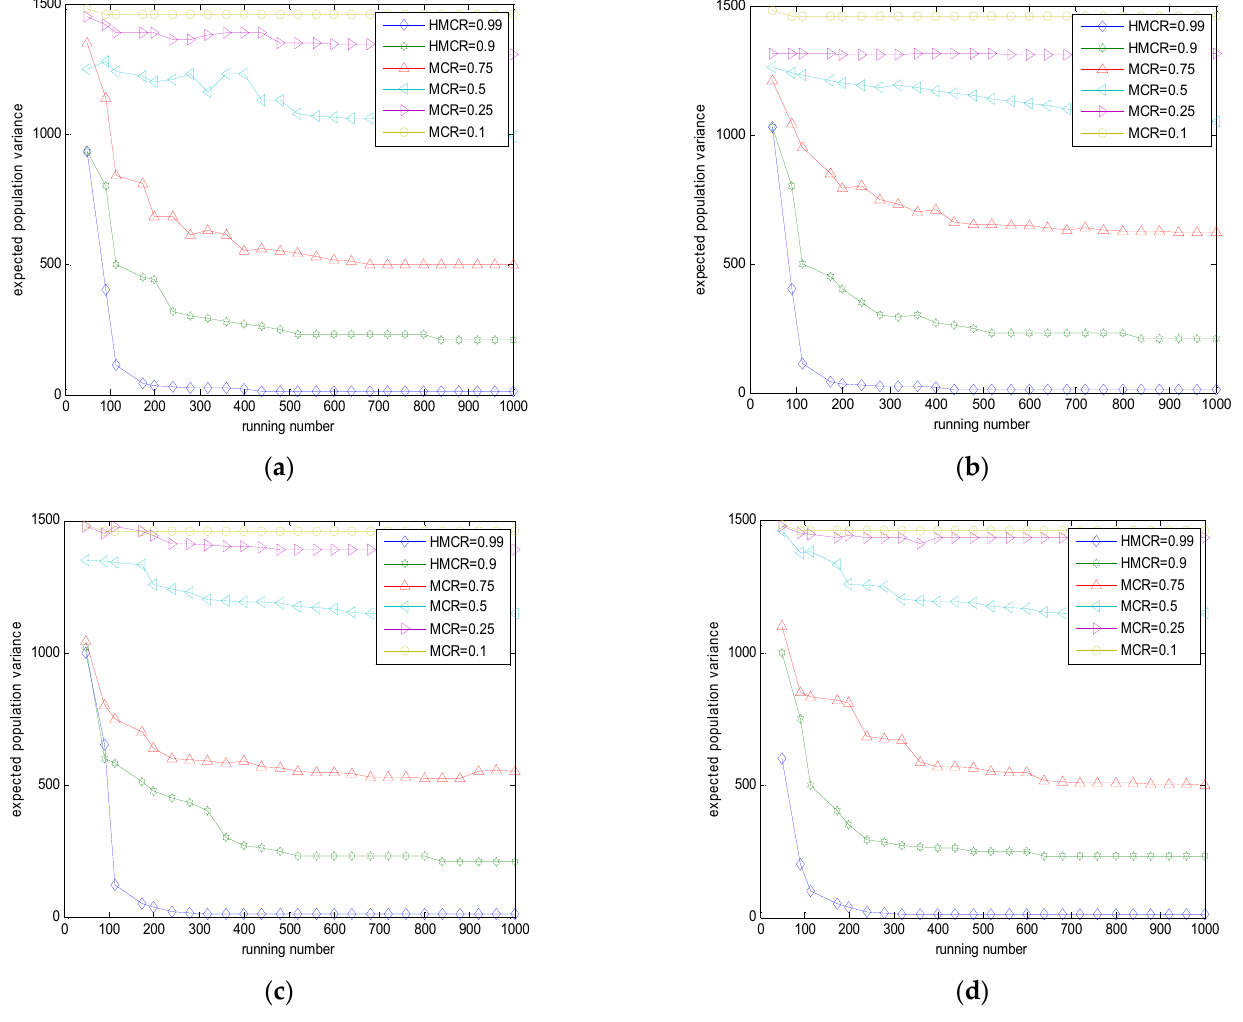
Figure 2. The expected population variance of OLPDHS with HMCR value for Sphere and Rastrigin: ( a ) Sphere: [ − 50, 100]; ( b ) Sphere: [ − 100, 50]; ( c ) Rastrigin: [ − 50, 100]; ( d ) Rastrigin: [ − 100, 50].